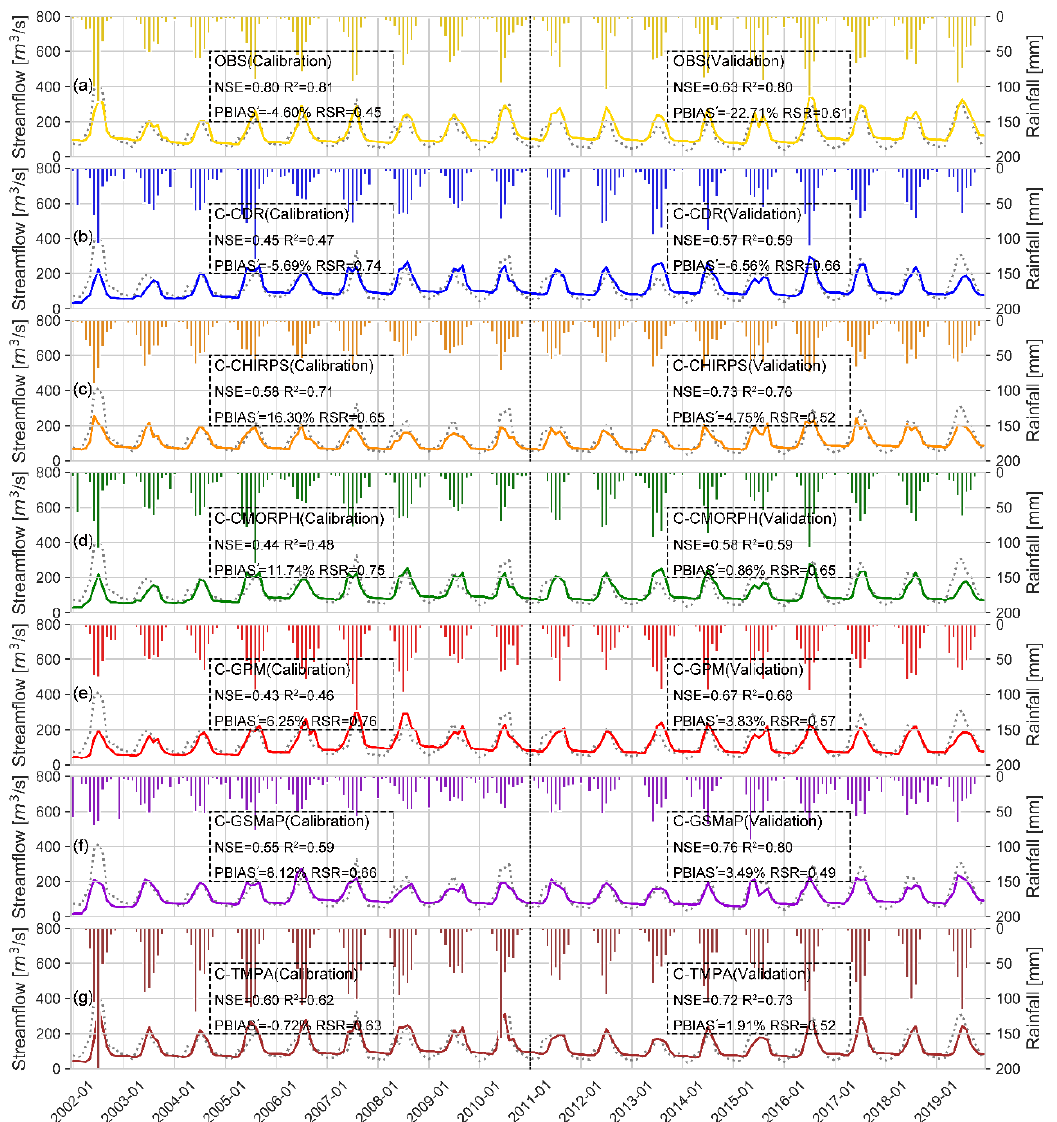
Figure 11. Average monthly precipitation and monthly streamflow simulation results of NW station data and six corrected satellite datasets in the calibration period (2002–2010) and the validation period (2011–2019).( a ) Observed data, ( b ) CDR, ( c ) CHIRPS, ( d ) CMORPH, ( e ) GPM, ( f ) GSMaP, ( g ) Table 3. Hydrological model performance under different input datasets.